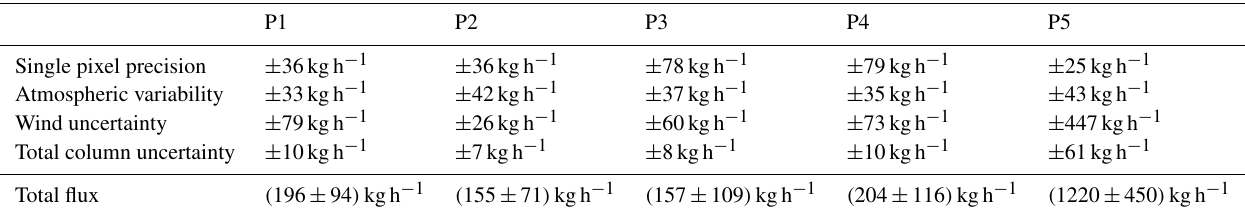
Table 6. Inversion results and uncertainty estimate using the cross-sectional flux method for P1 and P2 (two overpasses of the same source on 2 consecutive days), P3, P4, and P5. The single pixel precision was calculated from the 1 σ standard deviation of a background region for each plume. The atmospheric variability resulted from the confidence interval of the multiple cross-sectional fluxes. The wind uncertainty and total column uncertainty was assumed to be ± 1 . 5ms − 1 and 5%, respectively (see also text for explanation). For all inversions, the wind speed uncertainty is a very large uncertainty. While additionally for P2, the atmospheric variability induces similar large errors, for P3 and P4 this is much less the case. However, there the different surfaces lead to a much larger single pixel uncertainty. For P5, the error is dominated by the wind speed uncertainty. P1 P2 P3 P4